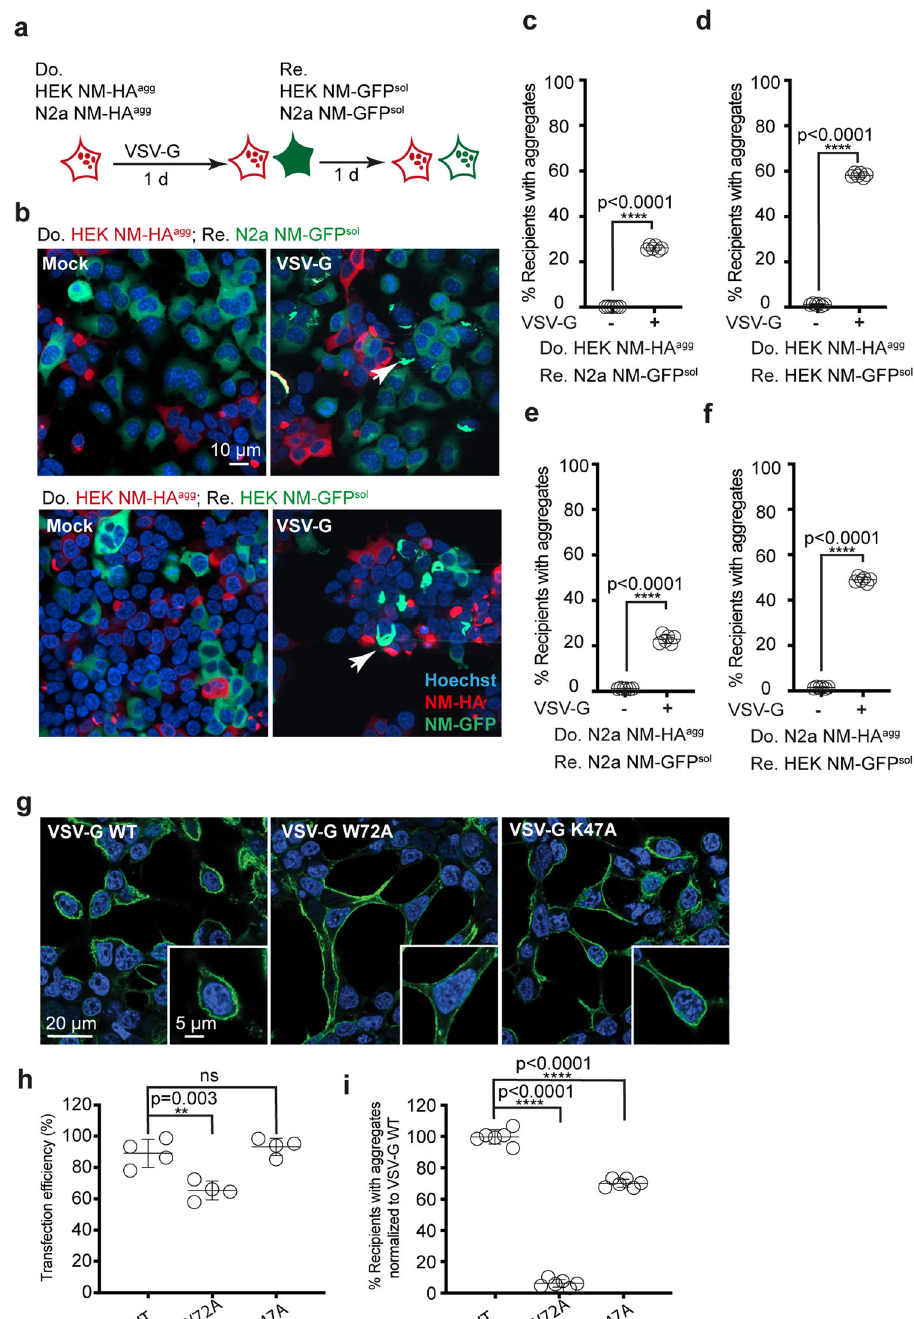
Fig. 1 VSV-G expression by donor cells increases induction of Sup35 NM prions in cocultured recipient cells. a A HEK NM-HA agg cell clone and a N2a NM-HA agg clone (red) with poor aggregate-inducing activity in recipients were chosen as donors (Do.). Donor cells were transiently transfected with plasmid coding for VSV-G or Mock transfected and cocultured with recipient cells expressing NM-GFP sol (Re.). b Transfected donor cells cocultured with recipient cells. Do Donor Re Recipient. NM-HA was stained using anti-HA antibodies. c – f Quantitative analysis of the percentage of recipient cells with induced NM-GFP aggregates (NM-GFP agg ). g Cell surface expression of VSV-G in donor HEK NM-HA agg cells. Cells were fi xed 24 h post transfection (VSV-G antibody 8GF11). Insets show individual cells. h . Transfection ef fi ciency in HEK NM-HA agg cells. Shown is the percentage of cells expressing VSV-G. i . VSV-G (WT) or VSV-G mutant transfected donor cells were cocultured with recipient HEK NM-GFP sol cells. NM-GFP aggregate induction was determined 1-day post coculture. Induction rates related to WT VSV-G expression were set to 100 %. All data are shown as the means ± SD from four ( h ) or six ( c – f , i ) replicate cell cultures. Three ( c – f , h , i ) independent experiments were carried out with similar results. P values were calculated by two-tailed unpaired Student´s t test ( c – f ) or one-way ANOVA ( h , i ). Source data are provided as a Source Data fi le.